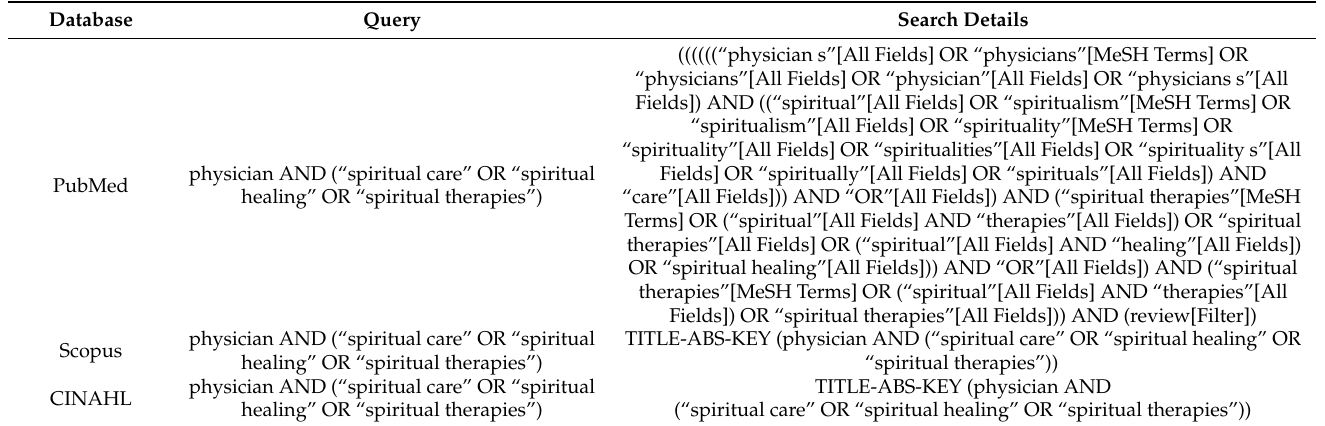
Table 1. Strategy search.